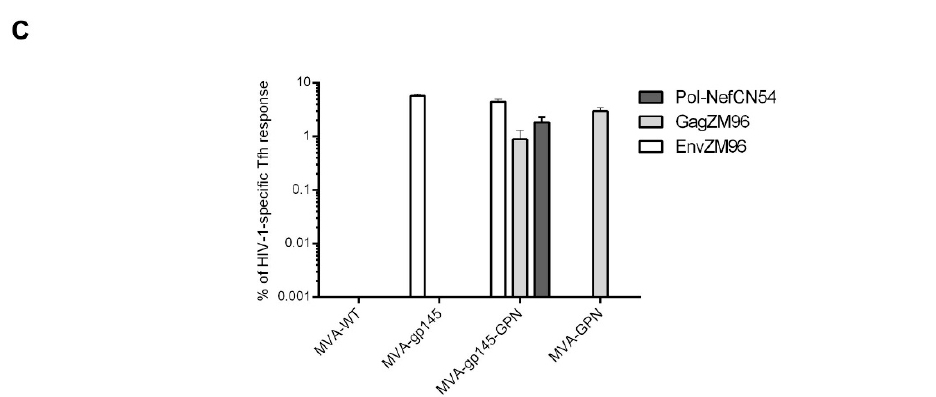
Figure 4. HIV-1-specific Tfh cell immune response elicited in spleen after prime/boost homologous immunization of mice with different MVA-based recombinant viruses expressing gp145 and/or GPN antigens. ( A ) Flow cytometry strategy for the identification of total ( B ) or HIV-1-specific ( C ) Tfh cells in splenocytes from immunized mice. Singlets were gated on lymphocytes followed by selection of live cells. CD4 + CD8 − cells were then gated and analyzed based on the expression of the CXCR5 and PD-1 markers. The double positive CXCR5 + PD-1 + population was used to identify total Tfh cells. HIV-1-specific Tfh cells were determined by the percentage of CXCR5 + PD-1 + cells that produce IFN- γ and/or IL-4 and/or CD40L. FSC-A: forward-scatter area; FSC-H: forward-scatter height; SSC-A: side scatter area. ( B ) Magnitude of the total CD4 T cells with Tfh phenotype (CXCR5 + PD1 + ) in spleen measured 10 days after the last immunization by ICS assay in non-stimulated (RPMI) lymphocytes derived from immunized animals. All the data are background-subtracted. ***, p < 0.001. ( C ) Magnitude of the HIV-1-specific Tfh cells in spleen. The total value in each group represents the sum of the percentages of Tfh + T cells producing IFN- γ and/or IL-4 against HIV-1 peptide pools. All data are